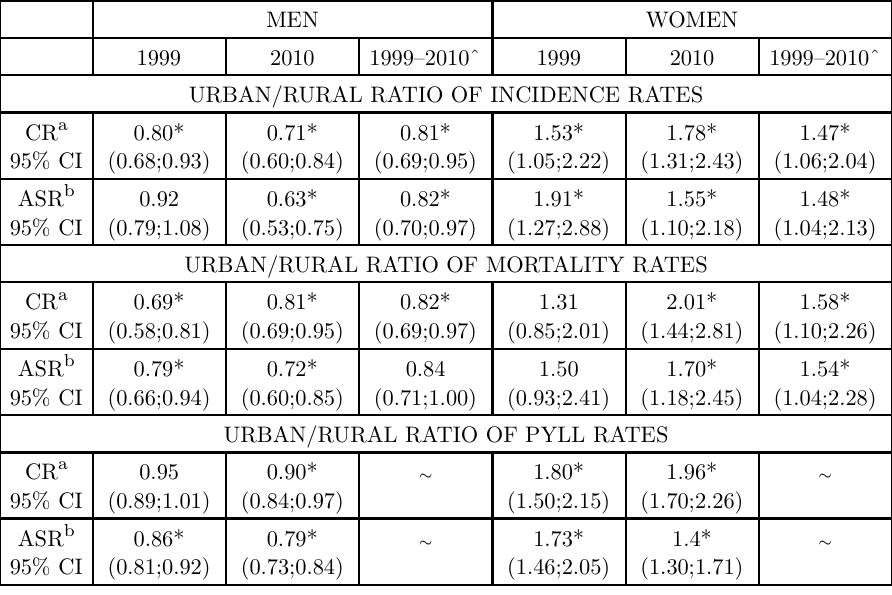
Table 3. Urban/rural ratio of lung cancer incidence. Mortality and PYLL rates from 1999–2010 in the Świętokrzyskie Province